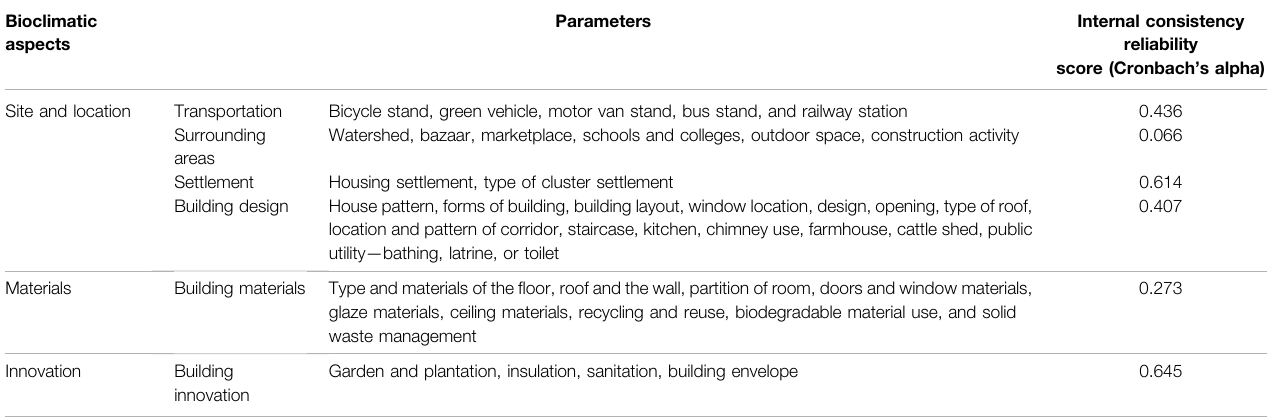
TABLE 2 | Survey questionnaire on bioclimatic aspects of rural coastal dwellings. Bioclimatic